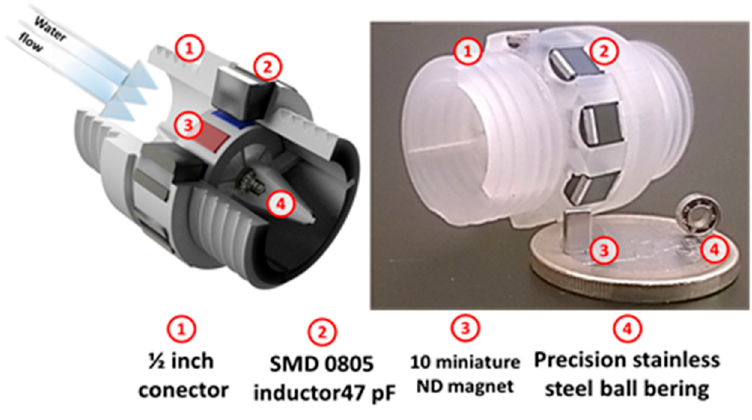
Figure 1. 3D printed water miniature turbine: ( a ) visualized cross section view, ( b ) printed structure and other main components-neodymium magnets, coils and stainless steel bearing.